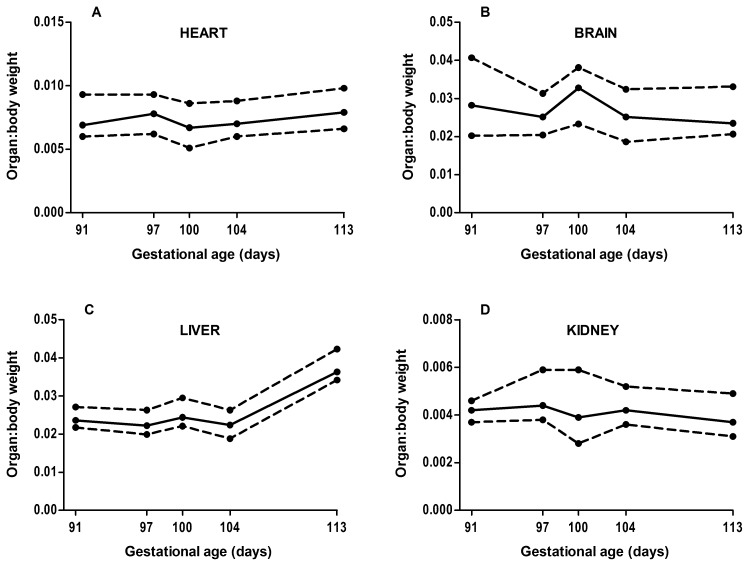
Relative organ growth from 91d to 113d of gestation (term = 115d) for A) heart, B) brain, C) liver, D) kidney.The solid line is the 50th centile and the dashed lines are the 10th and 90th centiles. Note the weight of all organs increased proportionally with body weight, except for the liver which increased significantly relative to body weight between 104d and 113d (p = 0.004). Data from 94d was not included as only one litter was studied and few organ weights were recorded.